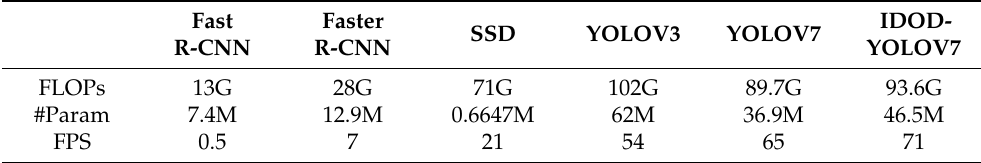
Table 6. Complexity analysis of different object detection